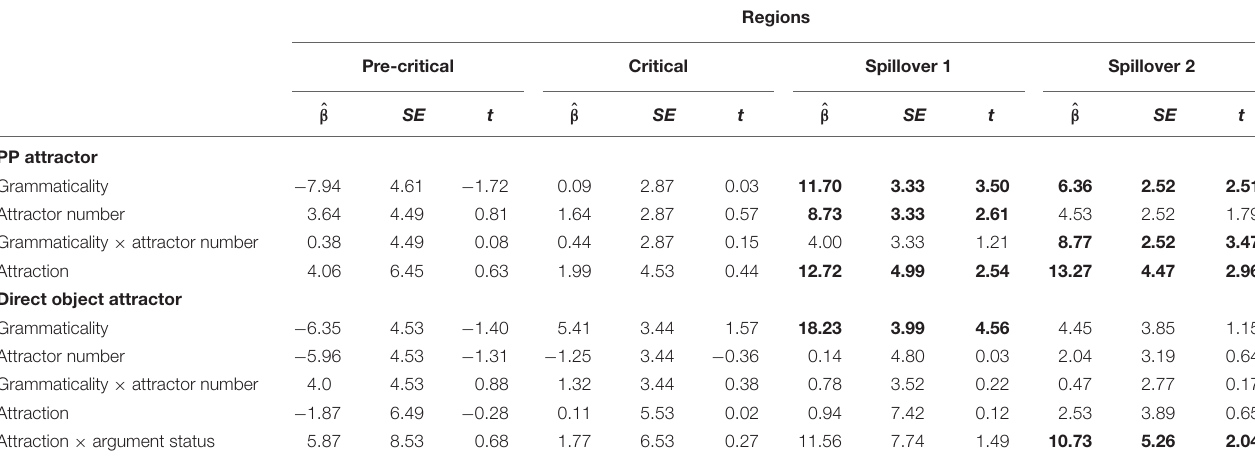
TABLE 3 | Summary of statistical analyses for PP attractor conditions and direct object attractor conditions in Experiment